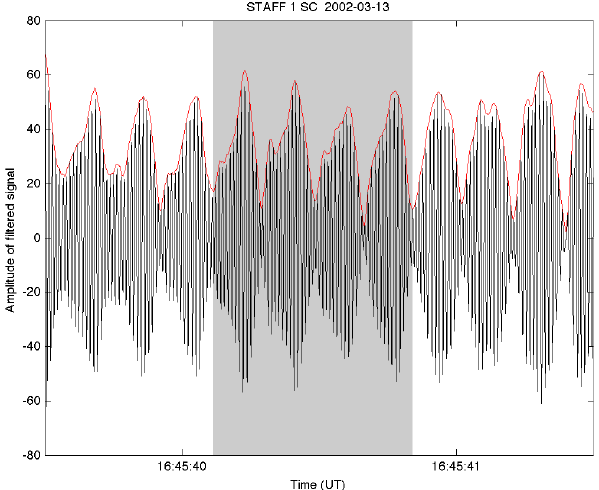
Fig. 3. Structure of wave packets observed by Cluster 1 (black) and Cluster 2 (red) on 13 March 2002 between 16:45:39.5 and 16:45:41.5UTC. In the top panel the two series are shown with their original time tags. In the lower panel, the Cluster 2 data has been shifted by 604ms to align it with the Cluster 1